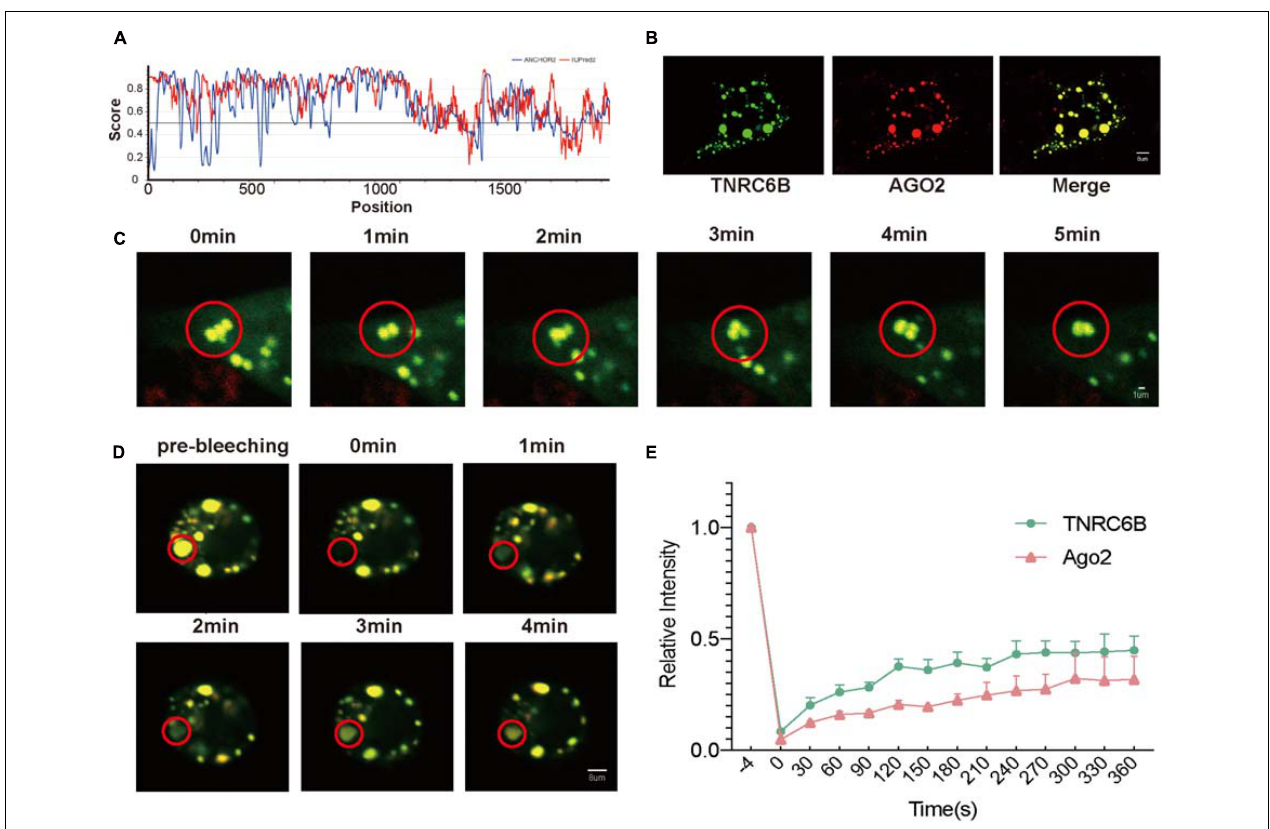
FIGURE 1 | LLPS of miRISC in colon cancer cells under over-expression condition. (A) Bioinformatics analysis of the IDR of TNRC6B, two methods were performed to assess the IDR regions, red lines represent IUPred2 and blue lines represents ANCHOR2, regions above 0.5 represents IDR regions. (B) Co-localization of Ago2 and TNRC6B in RKO cells, and they could condense into large, spherical droplets. Green droplets represent TNRC6B and red droplets represents Ago2, yellow droplets represent the merge of both of 2 colors. (C) Droplets could move and fuse along with time elapse, yellow droplets represent the merge of both TNRC6B and Ago2. (D) Fluorescence intensity of Ago2 and TNRC6B recover slowly after photobleaching. Regions inside the red circle represent photobleaching regions. Yellow droplets mean the merge of both Ago2 and TNRC6B. (E) Fluorescence intensity of TNRC6B and Ago2 could recover after photobleaching along with time elapse, separately. Green line represents intensity of TNRC6B, red line represents intensity of